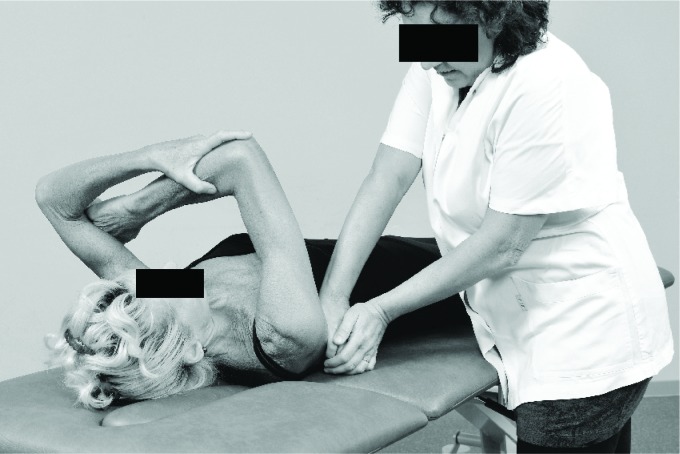
Cross body stretch9.